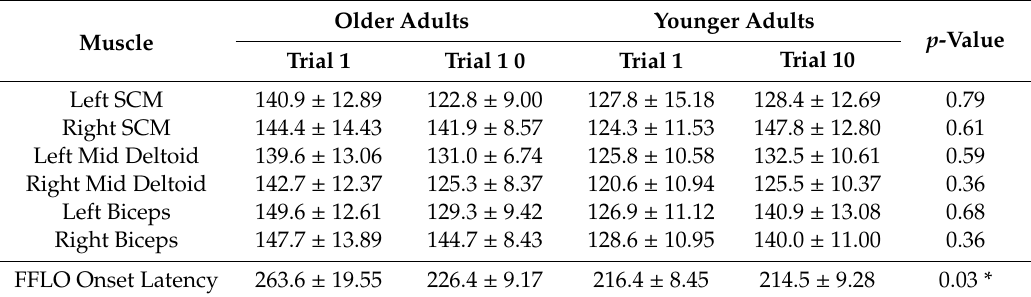
Table 1. Mean ± standard error of onset latencies for older and young adult (ms).